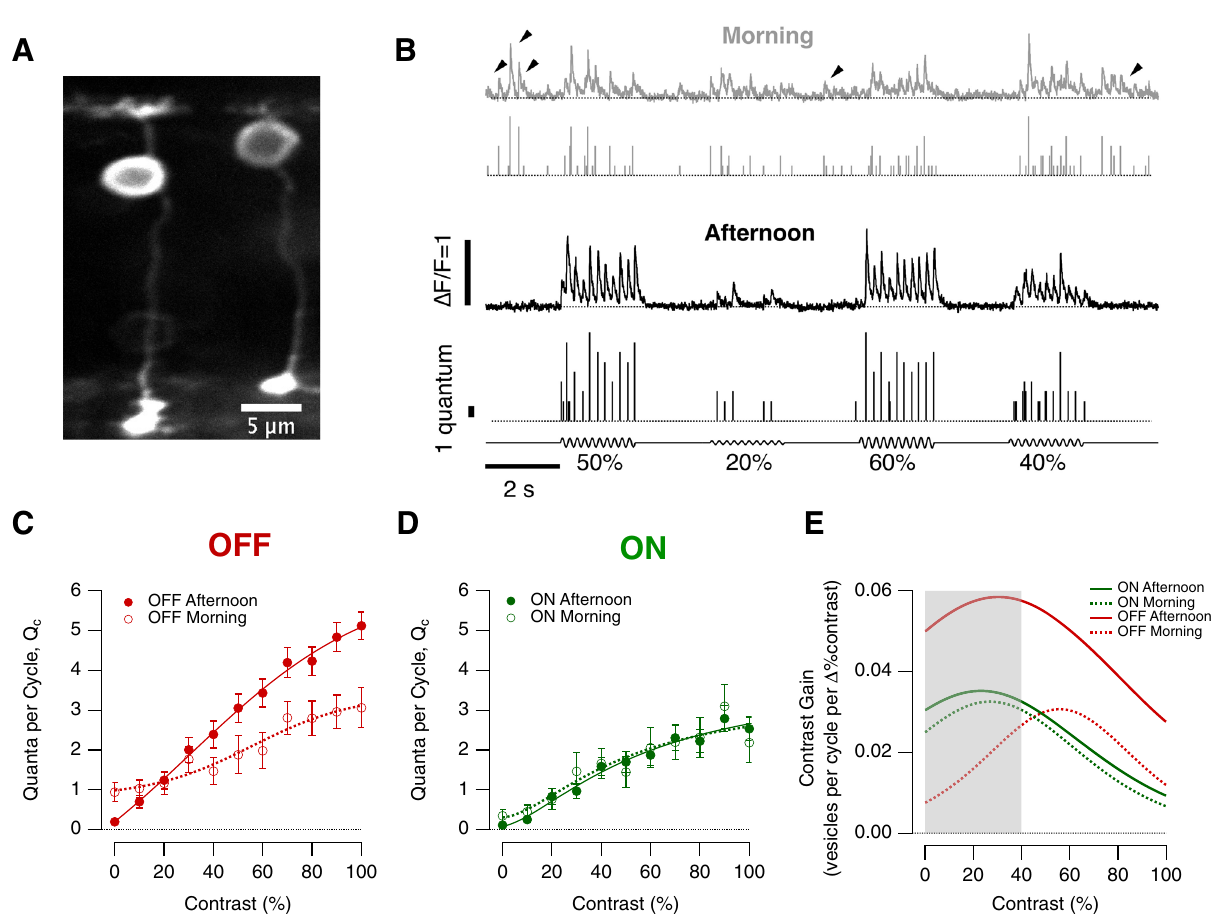
Fig. 2 Diurnal modulation of synaptic gain. A Multiphoton section through the eye of a zebra fi sh larva (7 dpf) expressing iGluSnFR in a subset of bipolar cells. B Examples of iGluSnFR signals from an individual OFF synapse elicited using stimuli of variable contrast modulated at 5 Hz (0 – 100%, full fi eld, sine wave) in the morning (ZT 0 – 2 h, grey) and afternoon (ZT 6 – 8 h, black). Note the high levels of spontaneous activity in the morning (black arrowheads). In each case the top trace shows the iGluSnFR signal and the lower trace the estimated number of quanta composing each event ( Q e ). C Average contrast- response functions in OFF bipolar cell synapses in the morning (open circles; n = 20 synapses) and afternoon (closed; n = 59), where the response ( R ) was quanti fi ed as the average of quanta per cycle, Q c (i.e., the total number of quanta released within a single cycle of the sinusoidal stimulus). Each point shows the mean ± s.e.m. The smooth lines are fi ts of a sigmoid used for smoothing. Note the differences in the shape of the contrast-response functions and in the levels of spontaneous activity (zero contrast) (One-way ANCOVA test, p < 0.0006). D Average contrast-response functions in ON bipolar cell synapses in the morning (open circles; n = 12 synapses) and afternoon (closed; n = 31). There was no signi fi cant difference in the morning relative to afternoon. (One- way ANCOVA test, p = 0.53) Each point shows the mean ± s.e.m. E The contrast gain calculated as the derivative of the fi ts to the contrast-response functions in ( C , D ). The grey box provides an indication of the contrasts most common in nature (below about 40%). Note that the maximum contrast discrimination is increased by a factor of 2x in the OFF channel during the afternoon. Source data are provided as a Source Data fi